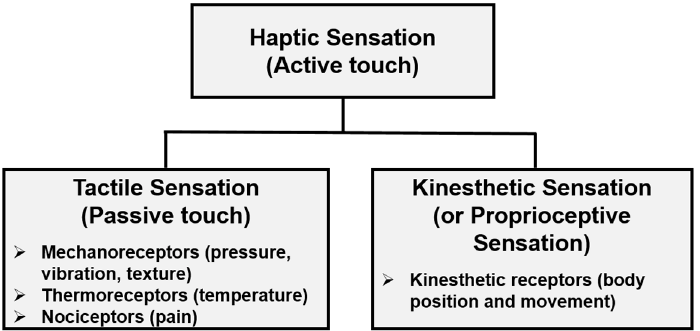
Figure 1. The concepts of terminologies commonly used in the literature associated with a sense of touch.